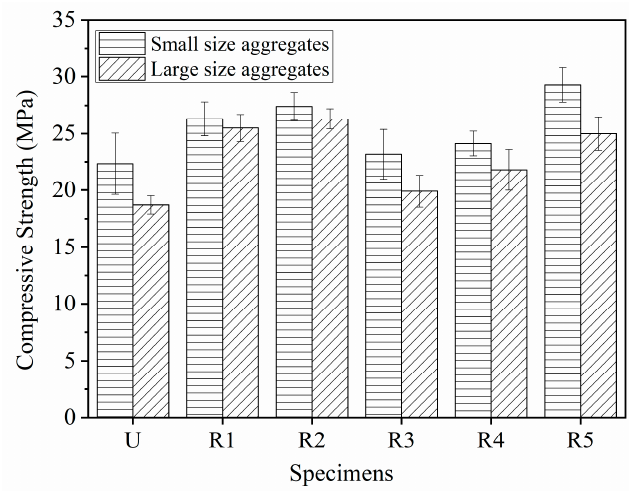
Figure 8. Compressive strength of pervious concrete specimens.